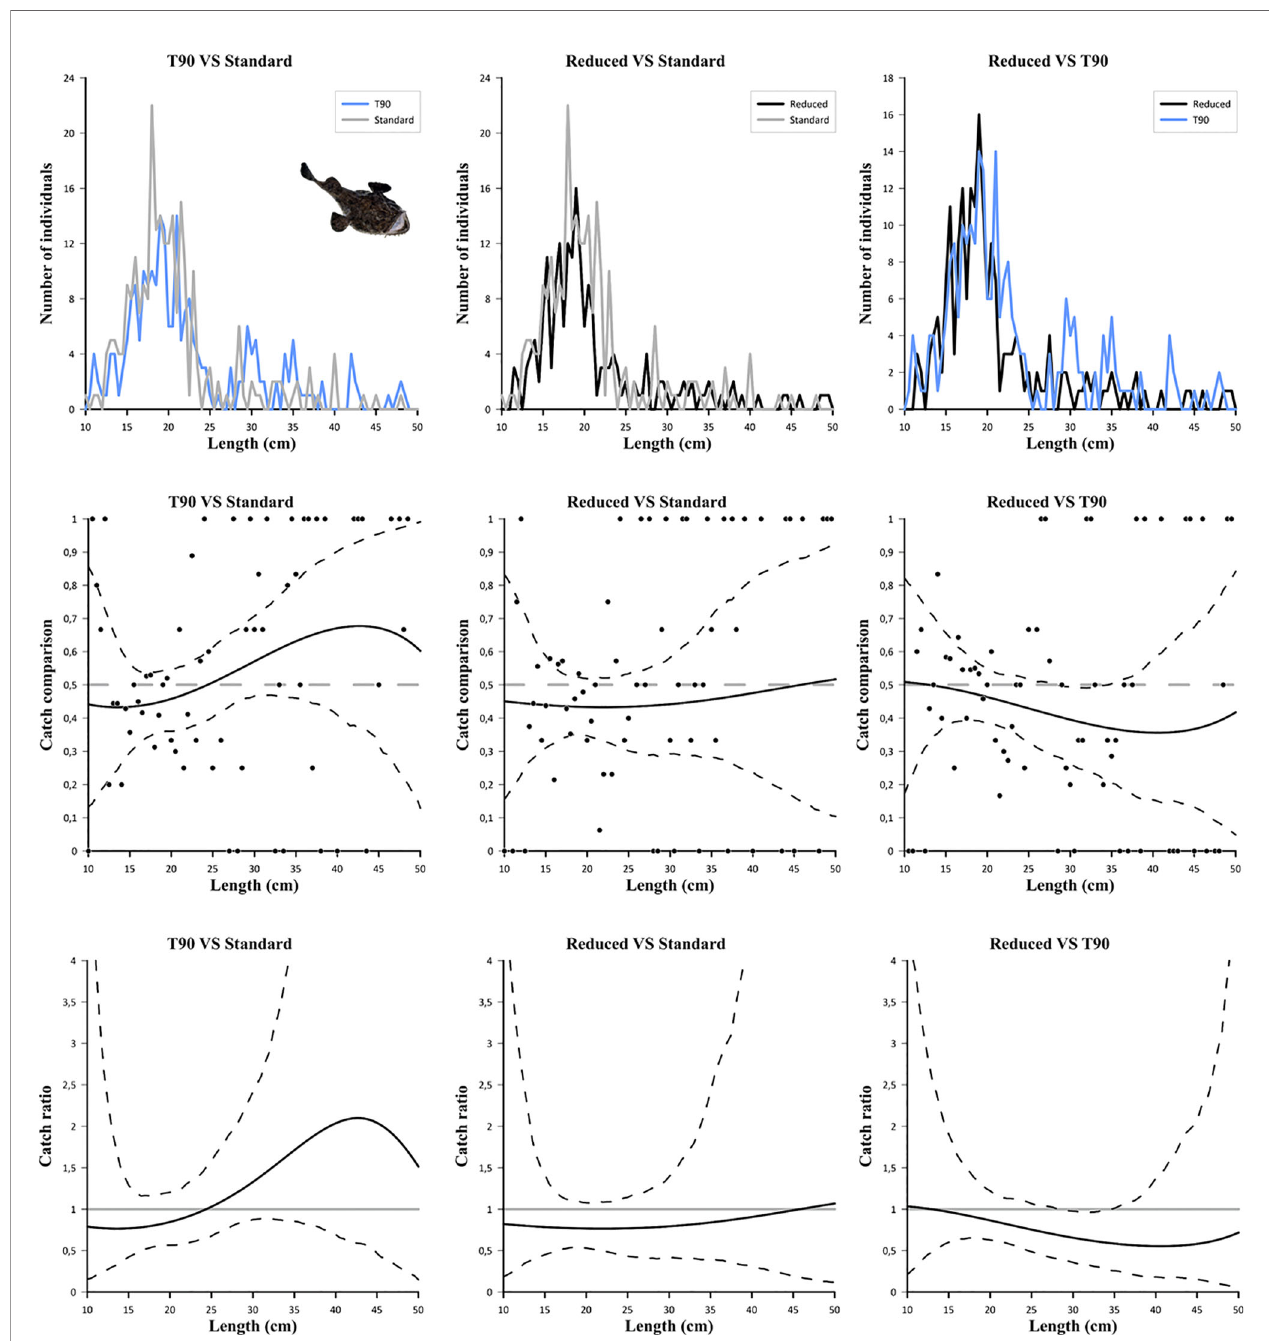
FIGURE 5 | Upper graph: Length frequency distribution of monk fi sh caught by the con fi gurations tested (Standard, Reduced and T90). Middle graph represents the modelled catch comparison rate, and lower graph the catch ratio (black line). Black circles represent the experimental rate, and black stippled curves represent 95% CIs . The grey horizontal line at 0.5 and 1.0 represents the point at which both con fi gurations have equal catch